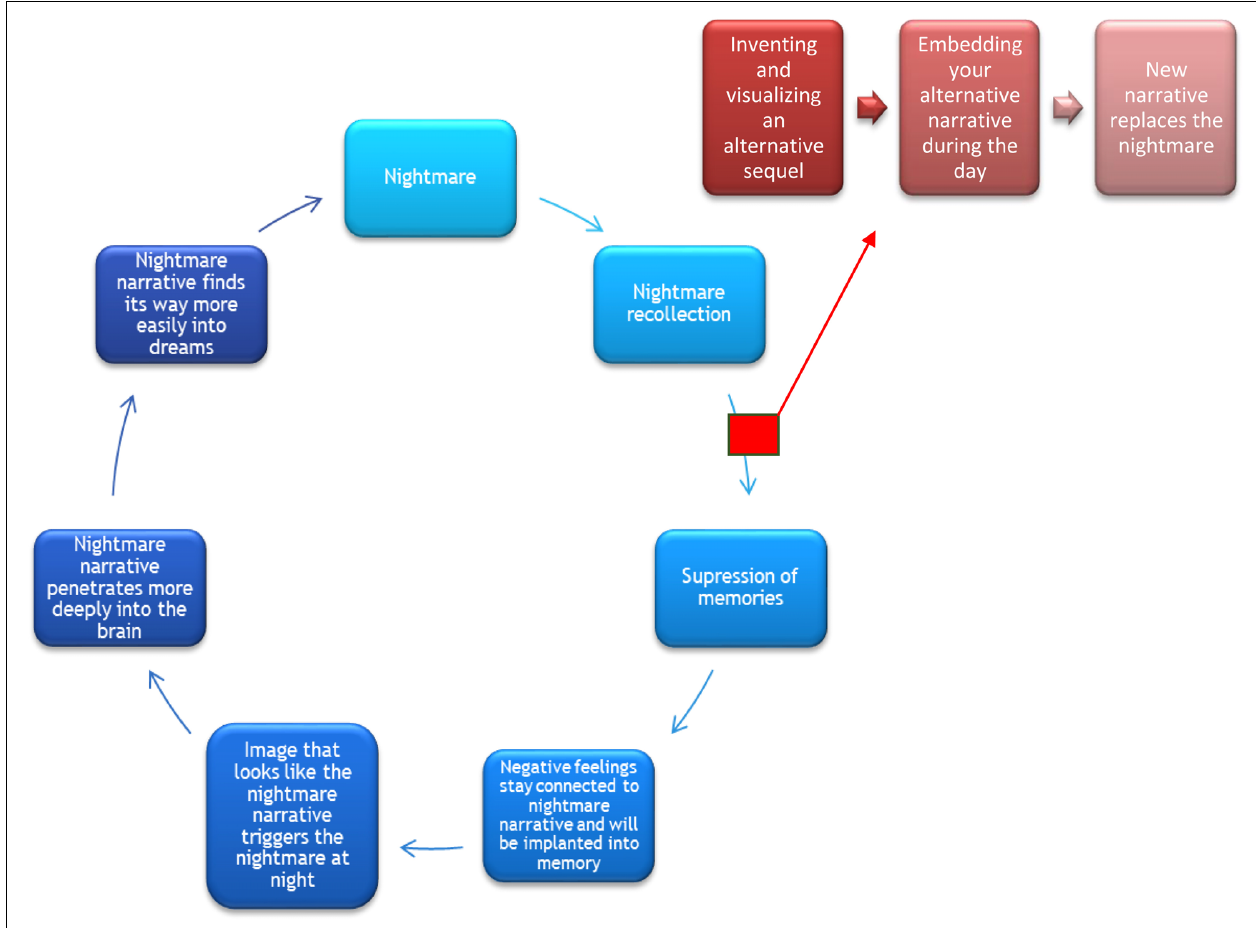
FIGURE 2 | Stopping the vicious circle of nightmares. From Nightmares in art therapy by Van Tuin and Versluys (2019). Addition to Van Schagen et al. (2012). Bohn Stafleu van Loghum Publishing. Reprinted with persmission.